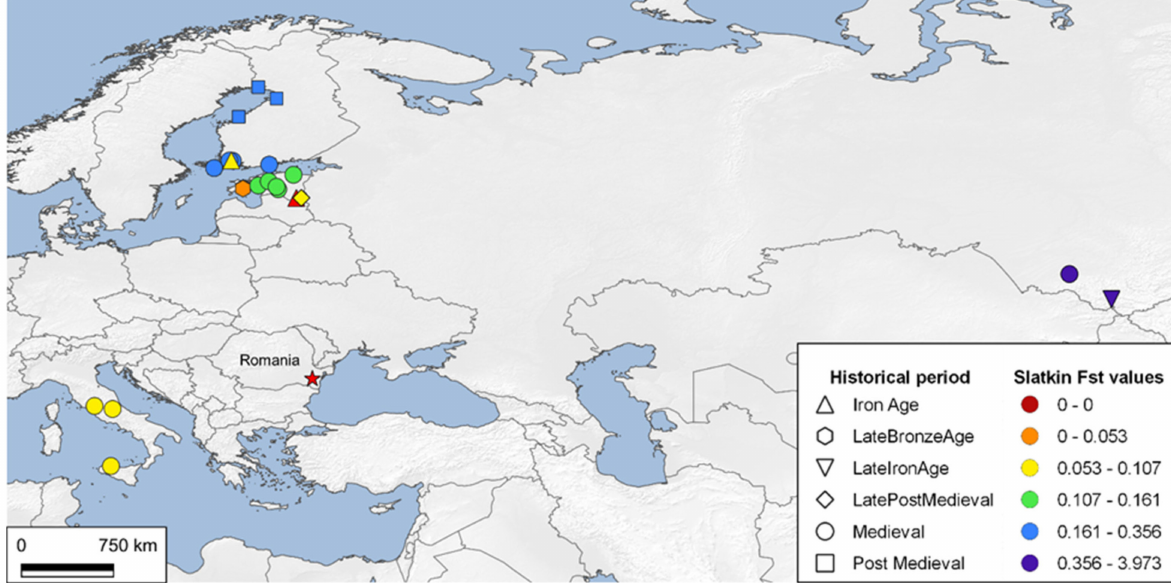
Figure 7. Geographic visualization of pairwise genetic differences between the Capidava cohort and the ancient sequences sets, displayed as Slatkin’s linearized Fst values, in heatmap